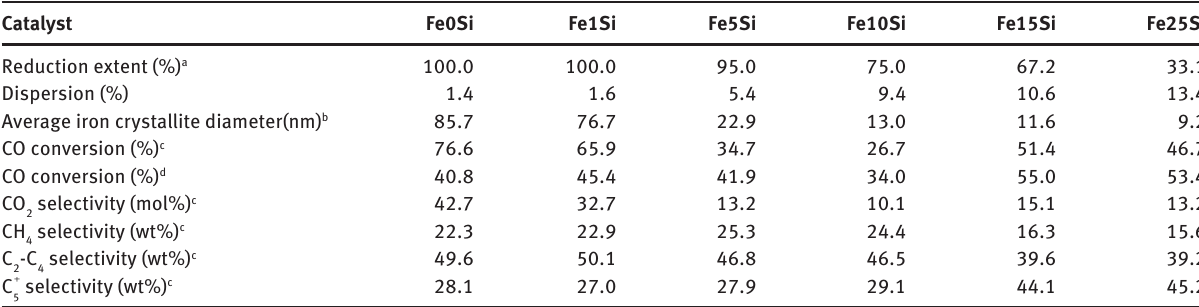
Table 2 Reduction extents, dispersions, and average iron crystallite diameters for Fe-Si